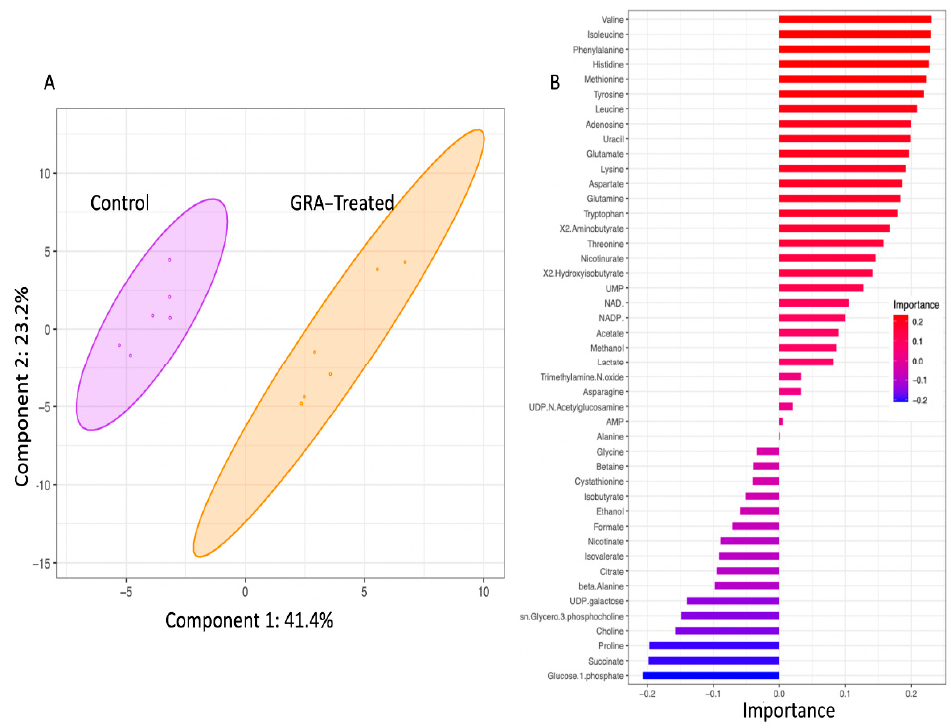
Figure 2. The 2D-PCA scores plot ( A ) and metabolites of importance associated with principal com- ponent 1 (PC1) of the PCA model ( B ). Multivariate statistical analysis of intracellular polar metabolite concentrations revealed distinct clustering of the untreated (purple) and 7.8 mg/L GRA treated (orange) bacteria. Shaded ellipses (shown in A ) represent 95% confidence intervals. Metabolites of importance plot for component 1 (shown in B ) indicate metabolite loading factors that contribute to the distinct separation of the two S. aureus cell culture groups along PC1 of the 2D PCA model; importance values of >0.10 or < − 0.10 (as shown on the x -axis of plot B ) are considered most noteworthy.